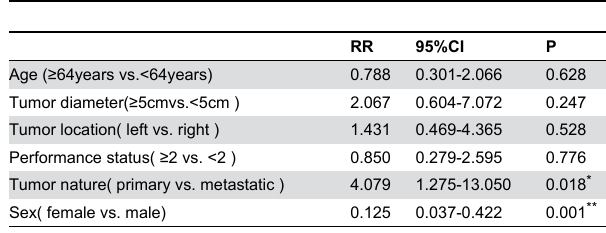
Figure 1. Kaplan-Meier plots. Overall survival for all patients (n=26). Table 4. Univariate analysis for survival.